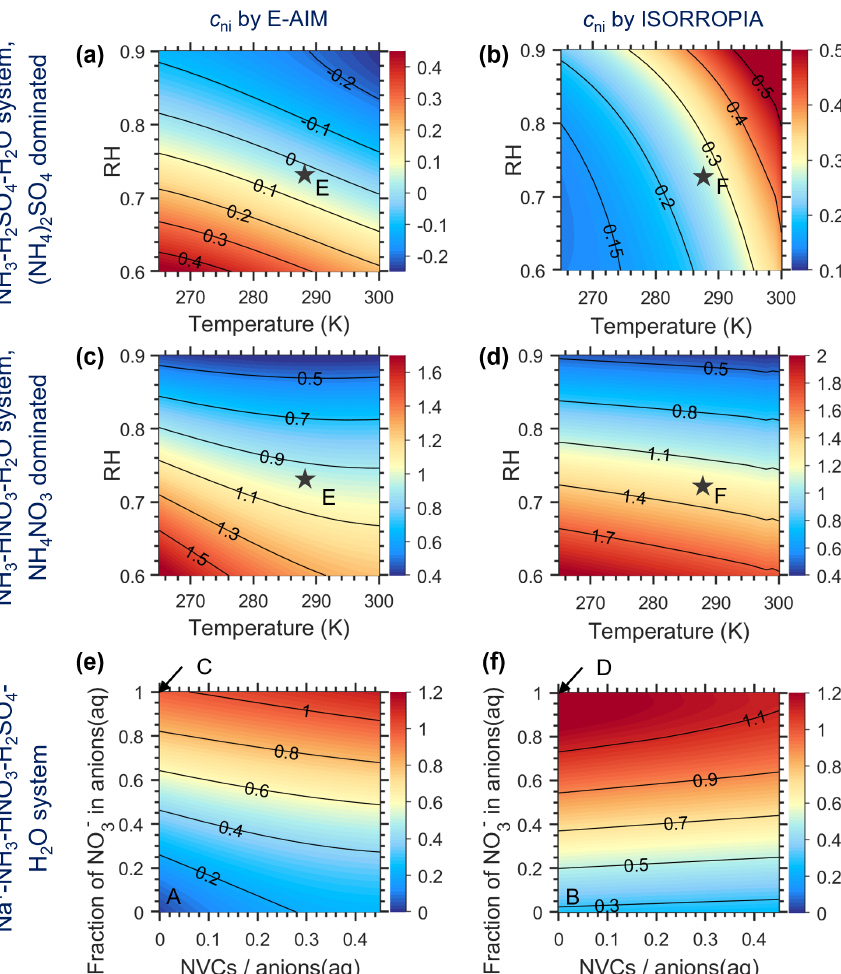
Figure 1. The non-ideality correction factor, c ni , estimated by E-AIM (a, c, e) and ISORROPIA (b, d, f) for different aerosol systems. (a, b) NH 3 –H 2 SO 4 –H 2 O system with aerosols dominated by (NH 4 ) 2 SO 4 at varying RH and temperature conditions; (c, d) NH 3 –HNO 3 –H 2 O system with aerosols dominated by NH 4 NO 3 at varying RH and temperature conditions, and (e, f) Na + –NH 3 –HNO 3 –H 2 SO 4 –H 2 O system with varying chemical profiles at 288.15K and RH of 73%. The chemical profiles in (e) and (f) are characterized by the fraction of NO − in anions(aq) and NVCs / anions(aq), where the non-volatile cations (NVCs) are assumed to be Na + only here. The assumed RH and T conditions in (e) and (f) are marked as blacked stars in (a) – (d) , while the chemical profiles of (a) – (d) are marked by the corresponding letter in (e) and (f) ,